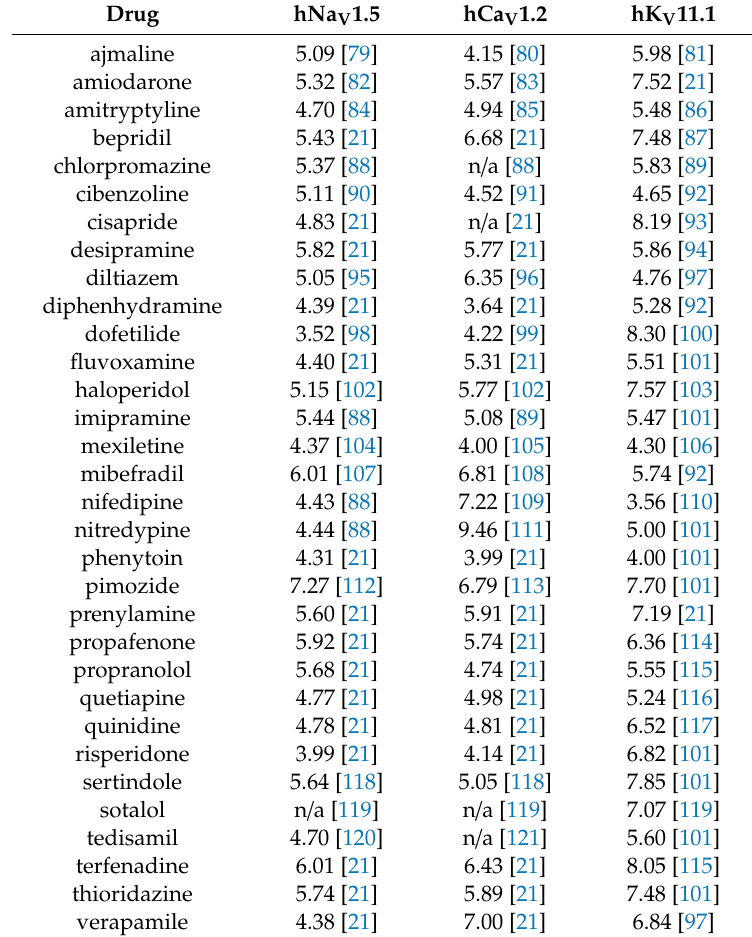
Table 2. Comparison of pIC 50 values (i.e., the negative logarithm of the IC 50 value) of selected